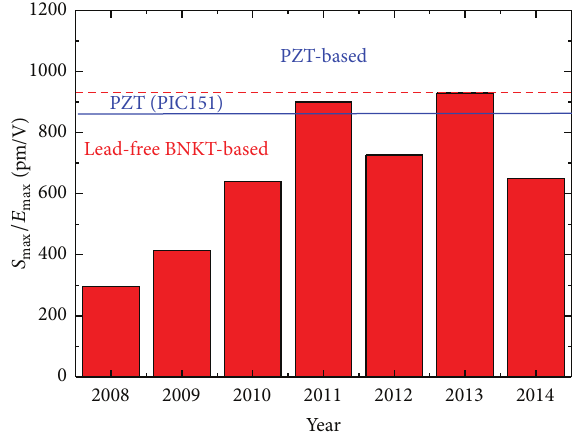
Figure 3: The highest values 𝑆 max /𝐸 max observation in years (from 2008 to 2014) in lead-free BNKT-based